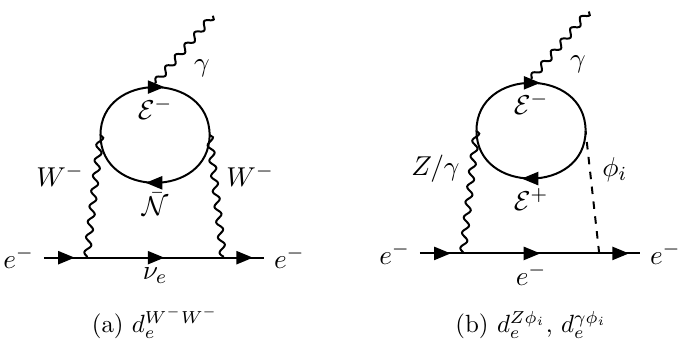
Figure 2. Electron EDM contribution arising from new interactions. CPV comes from either phases in the weak currents or phases in the new scalar-fermion interactions which arise through scalar mixing. Mirrored versions of the second diagram (i.e., Z